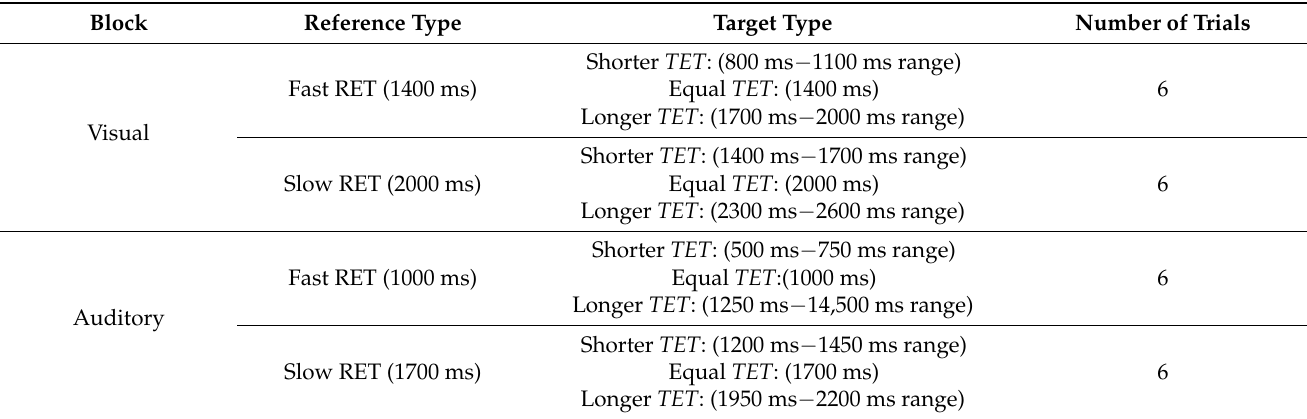
Table 2. Block design: 2 (RET condition) ∗ 3 ( TET condition) ∗ 6 (trials number) for visual and auditory stimuli